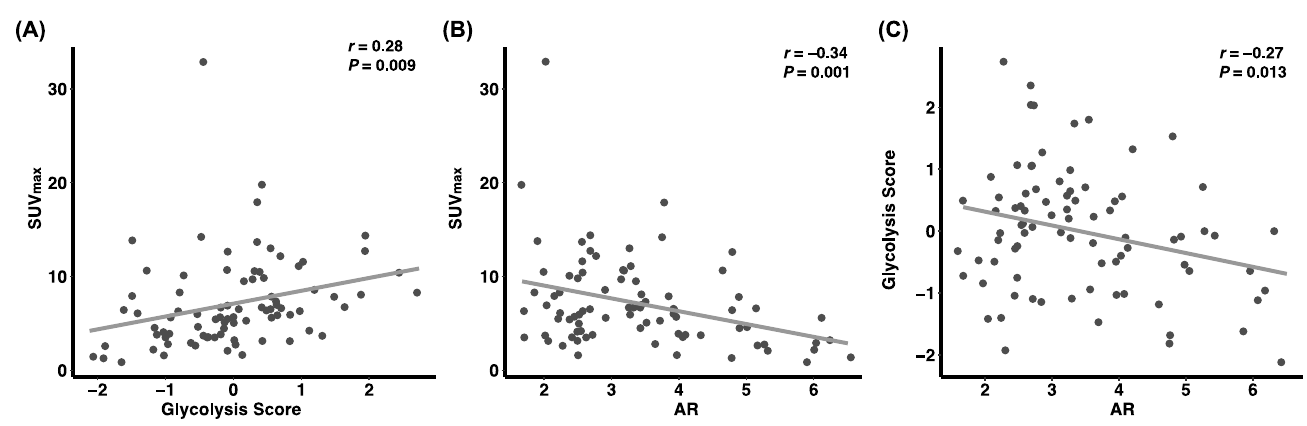
Fig 3. Correlations among AR, SUV max , and glycolysis-associated genes expressions analyzed using GSE135565 database. SUV max was well correlated with glycolysis score (A). A negative correlation between AR expression and SUV max was observed (B). The AR expression is inversely correlated with glycolysis score (C). AR, expression level of androgen receptor gene; Glycolysis score indicates how close gene expression pattern of a sample is, to expected expression pattern of the glycolysis-related gene set.